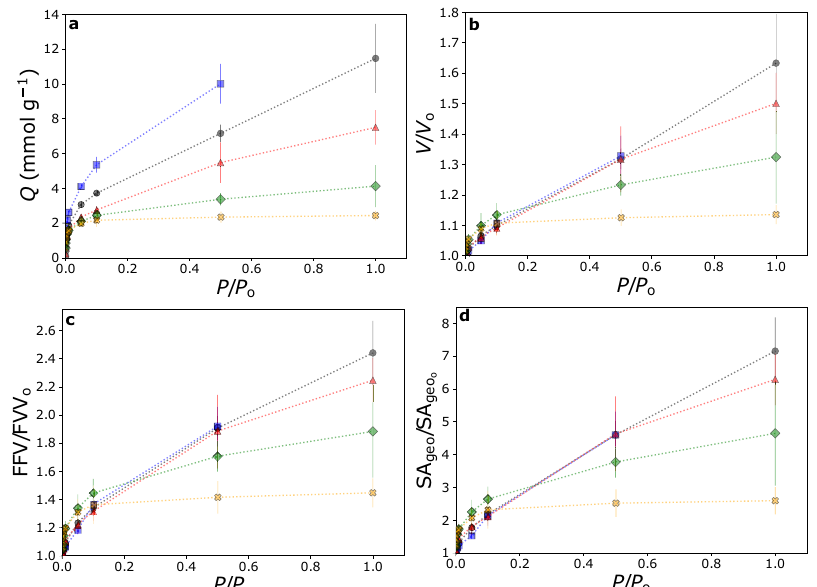
Fig. 1 CarboxyPIM-1 isotherms produced from sorption-relaxation (GCMC/MD) simulations at 300 K. Sorption-relaxation simulation data is shown for propene (black circles), acetaldehyde (blue squares), butane (red triangles), n-hexane (green diamonds), and dipropyl ether (orange crosses). a adsorption isotherm (loading denoted Q), b relative swelling (V/V o ), c fractional free volume (FFV) dilation, and d geometric surface area (SA geo ). Dotted lines are to guide the eye. Error bars indicate 95% con fi dence intervals (1.96 standard deviations) from simulations of independent